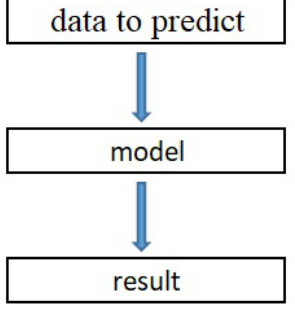
Figure 7. Model prediction